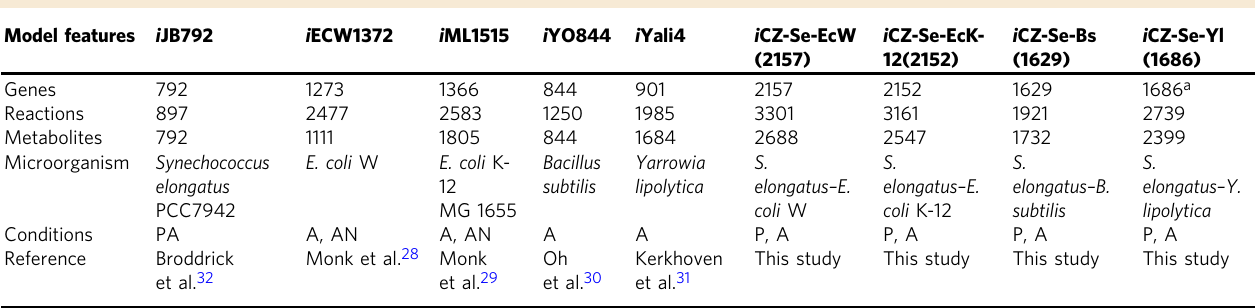
The fi rst row contains the names of the model. Each model can be simulated under different conditions: Phototroph models can be simulated under photoautotrophy (P), heterotrophy (H), and/or mixotrophy (M). Heterotroph models can be simulated under aerobic (A) and/or anaerobic (AN) conditions. Organelles: c cytoplasm, cx carboxysome, r endoplasmic reticulum, g Golgi apparatus, l liposome, p periplasm, m mitochondria, n nucleus, x peroxisome, t thylakoid, and v vacuole. *The consumption of ethanol was included into the Yarrowia model, adding genes and reactions.